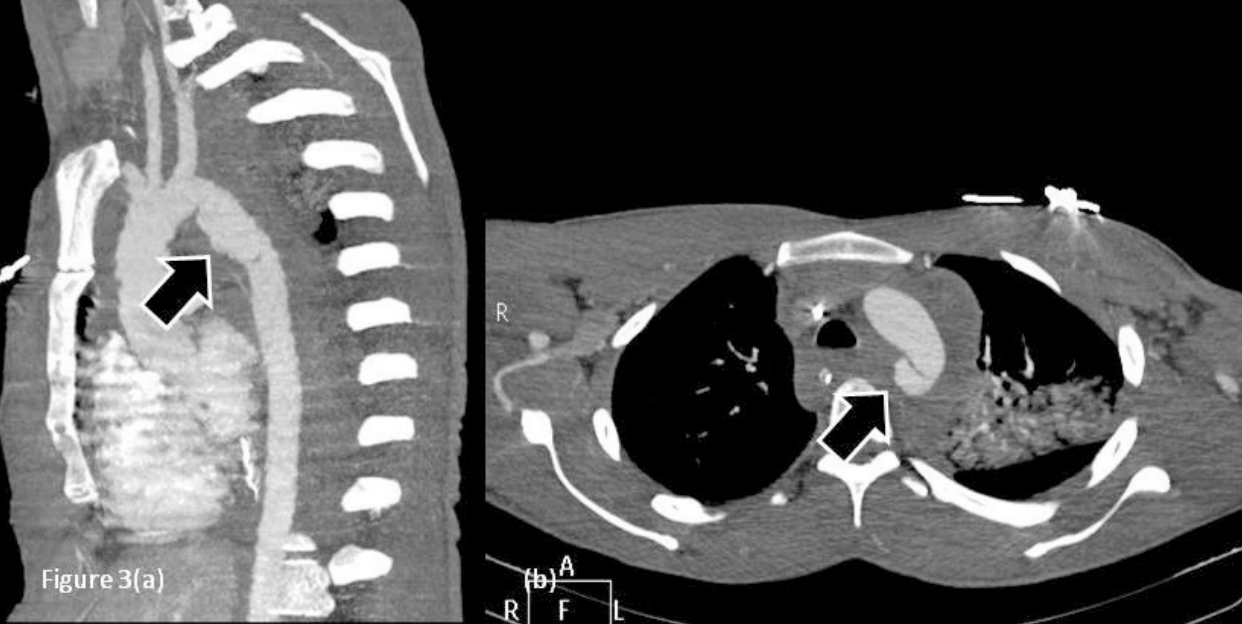
Fig. 3. CT angiography of the chest demonstrating a contained false aneurysm at the aortic isthmus (black arrows) in the (a) sagittal and (b) axial